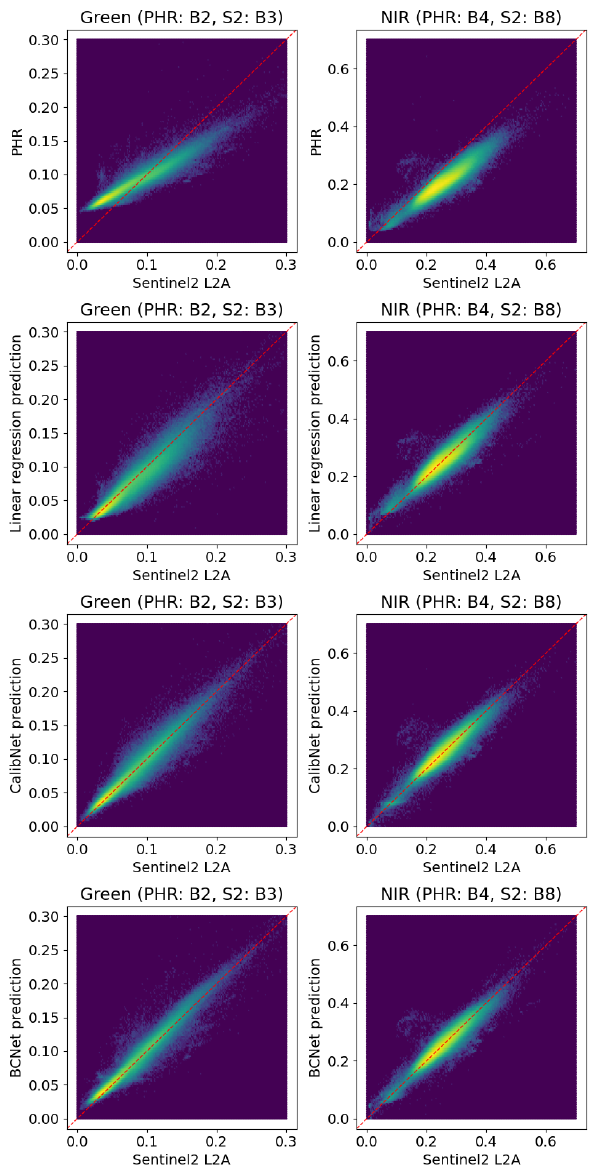
Figure 12. Scatter plot between Pleiades and Sentinel-2 surface reflectance for the Aude2 dataset, for all methods for Green and NIR bands (in this datasets Pleiades image contains Top of Atmosphere reflectances)